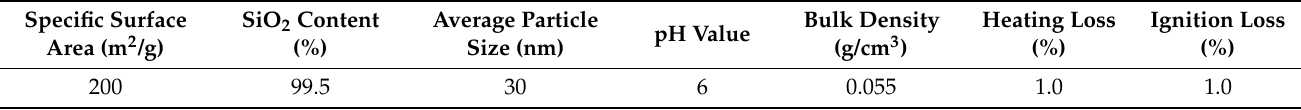
Table 3. Physical parameters of nano-SiO 2 [39].